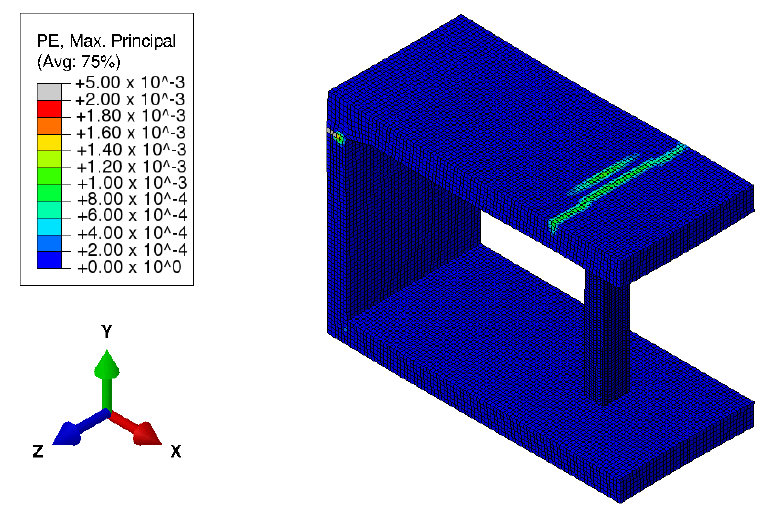
Figure 24. Plastic strains, developed on the outer surface of the top slab at its connection to the column right after the onset of cracking, as obtained from a thermomechanical simulation based on temperature-dependent and elasto-plastic material behavior, as well as on the prescription of one uniform surface temperature history; the results refer to the time instant 13 min and 50.7 s after the beginning of the fire